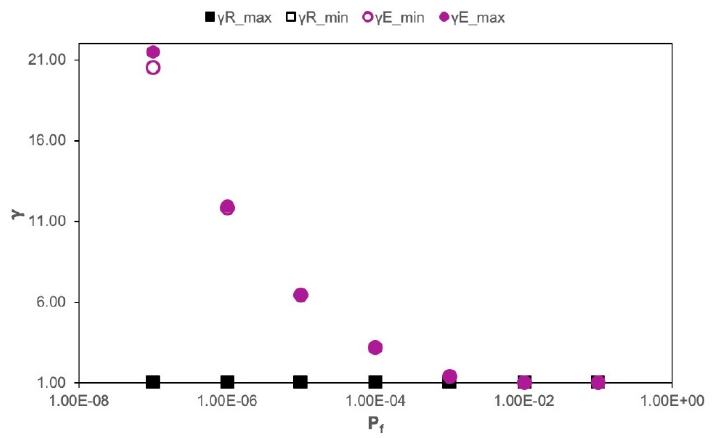
Figure 7. Partial factor dependence on barrier resistance and impact energy as a function of probability of failure considering the minimum (empty markers) and maximum (filled markers) fall height. Where not visible, maximum and minimum markers are overlapping. All the parameters are dimensionless.